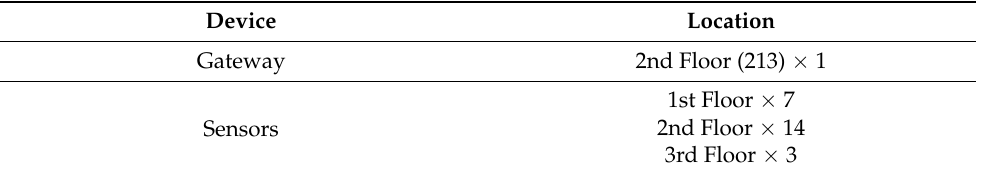
Table 2. Sensor module deployment.